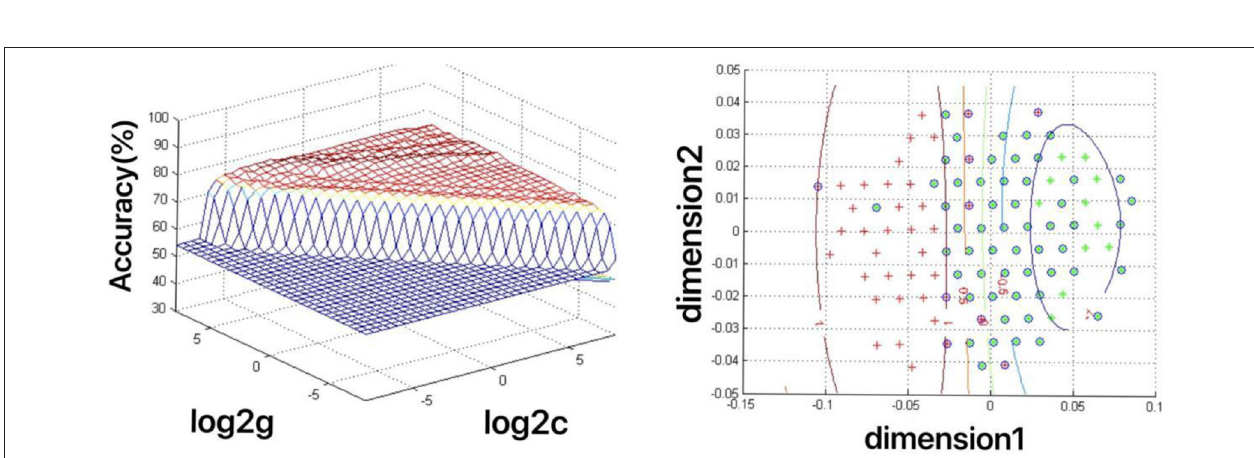
FIGURE 2 | Visualization of classifications through support vector machine (SVM) using the increased fractional amplitude of low-frequency fluctuation (fALFF) values in the left superior frontal gyrus (SFG) to discriminate the MDD patients from healthy controls. Left: SVM parameters result of 3D view. g means gamma, c means penalty coefficient. Right: Classified map of the fALFF values in the left SFG. Blue circle means true value and the red asterisk means predict value.